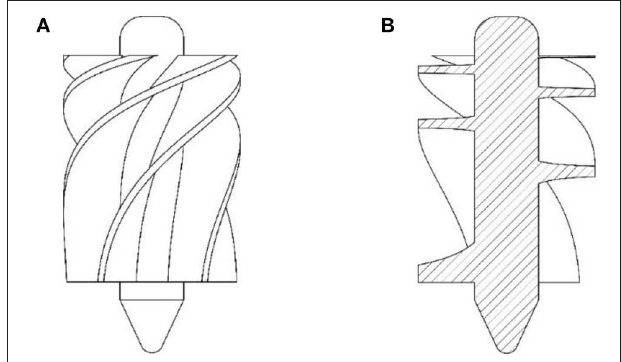
FIGURE 2 | The swirl element used in the gas-liquid separator. (A) Main view. (B) Section view.